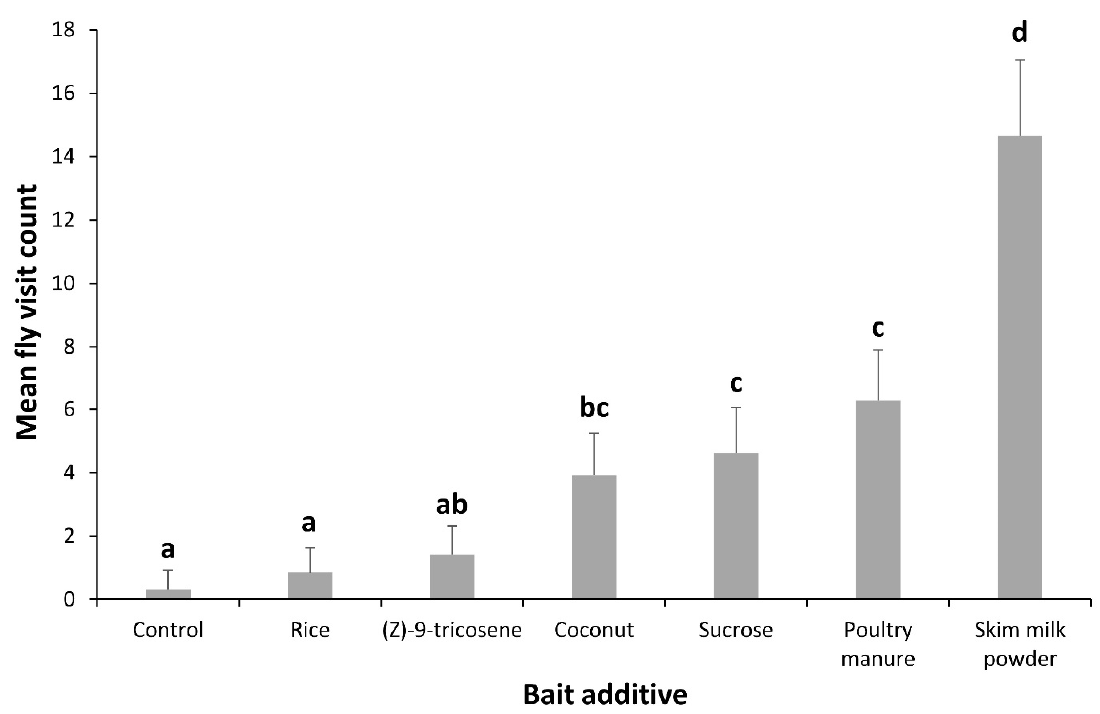
Figure 2. Mean fly visitation ( + SE) to trial bait formulations containing Metarhizium anisopliae M16 conidia mixed with various additives. Fly visit counts were made at 15 min intervals over a 3 h period. Means labelled with the same letter are not significantly different.